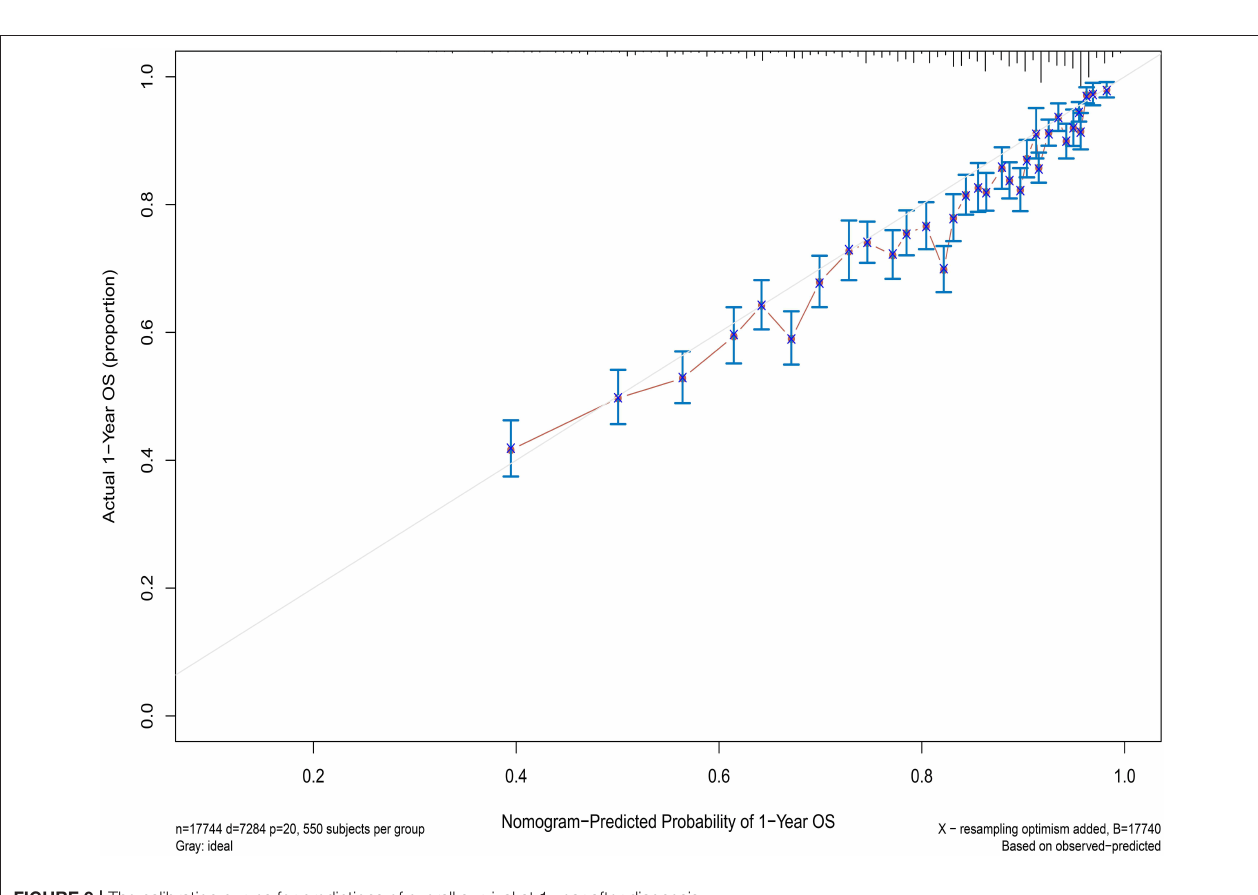
primary site, as an independent prognostic factor by multivariate COX, was added to this model. The prognostic value of this model was verified by C-index and the calibration curves, which are powerful in assessing the performance of a